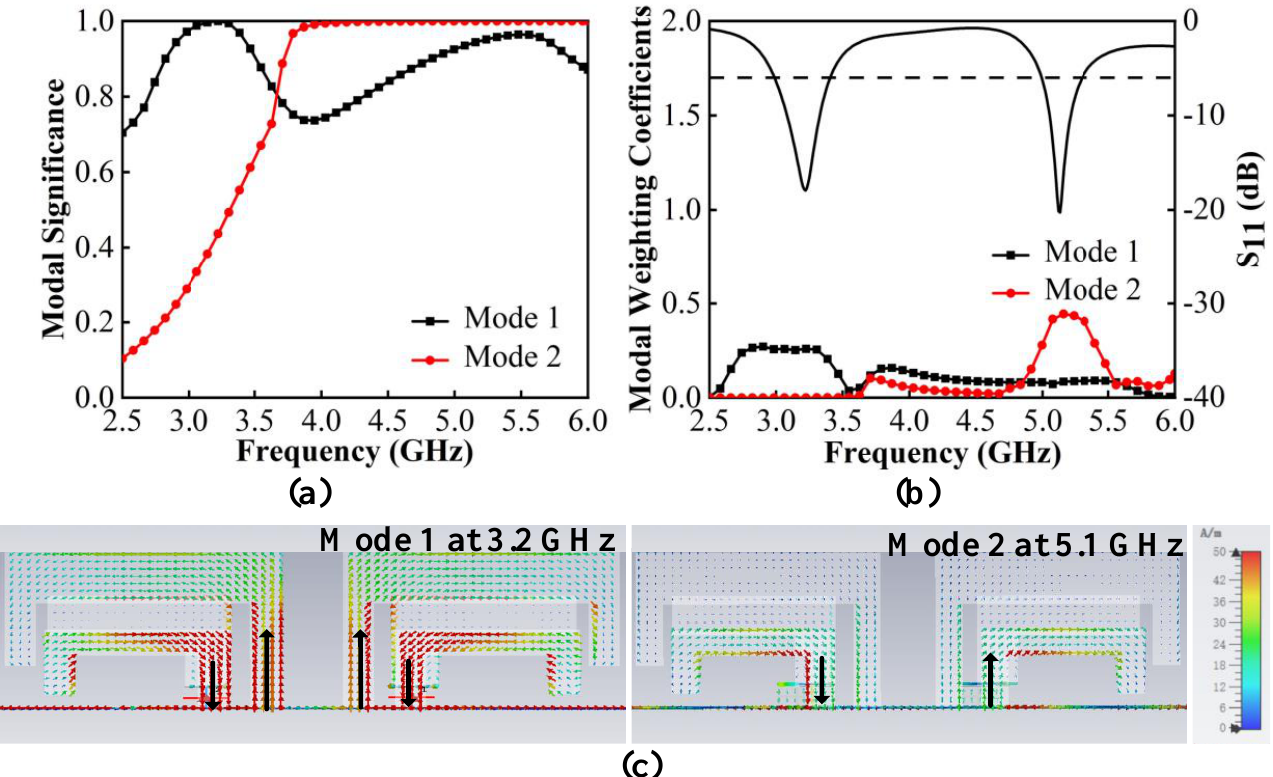
Figure 4. CMA of Case 1. ( a ) MS. ( b ) MWC. ( c ) Characteristic current distributions.